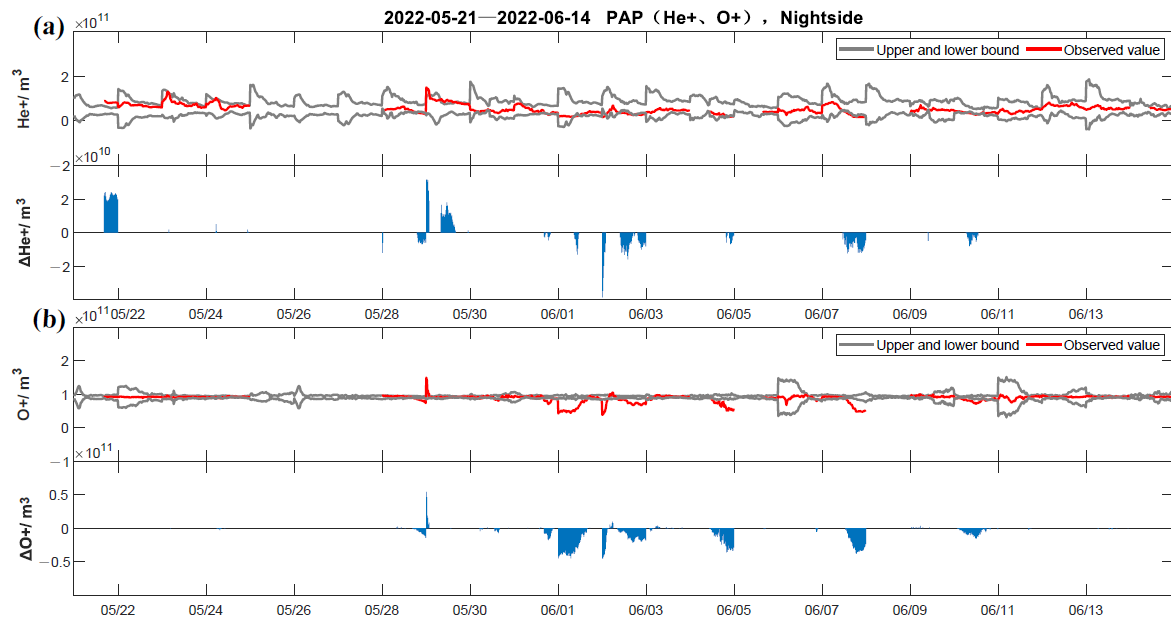
Figure 8. Temporal variations of He + and O + densities. ( a ) He + density; ( b ) O + density. The upper and lower bounds are shown in gray, and observed values are shown in red. The abnormal values are shown in blue, represented as ∆ He + and ∆ O + .